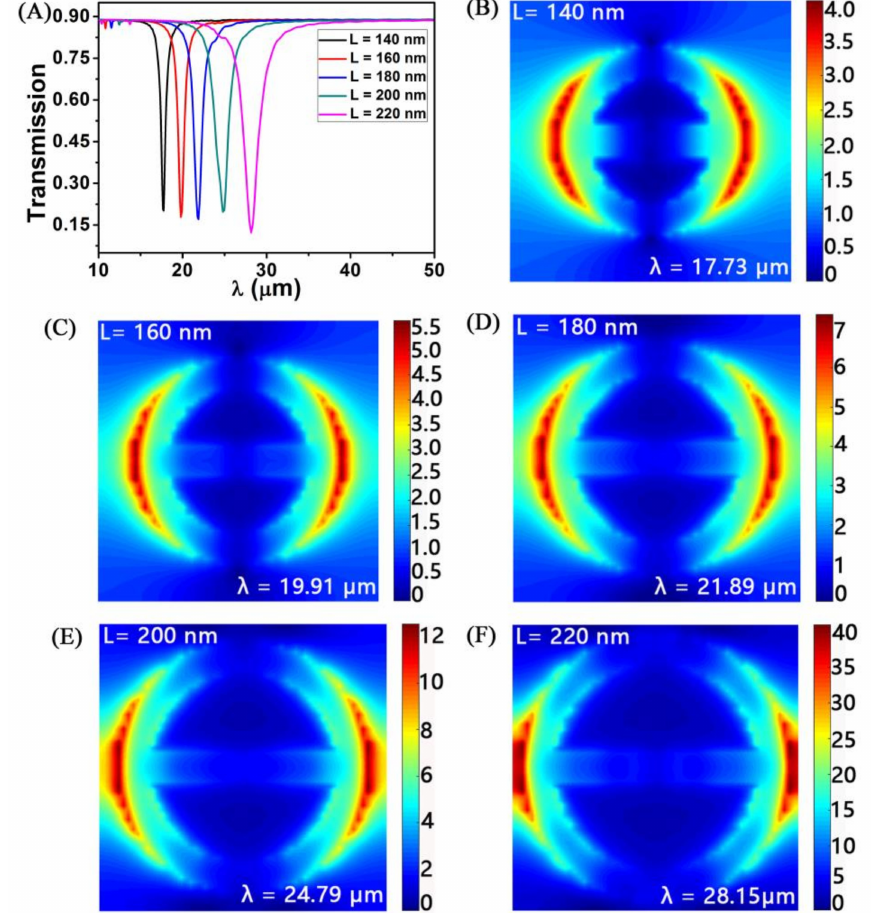
Figure 3. ( A ) The transmission spectra of graphene with different strip length ( L ). Structural parameters: and 220 nm the corresponding electric field distribution is labeled ( B )–( F